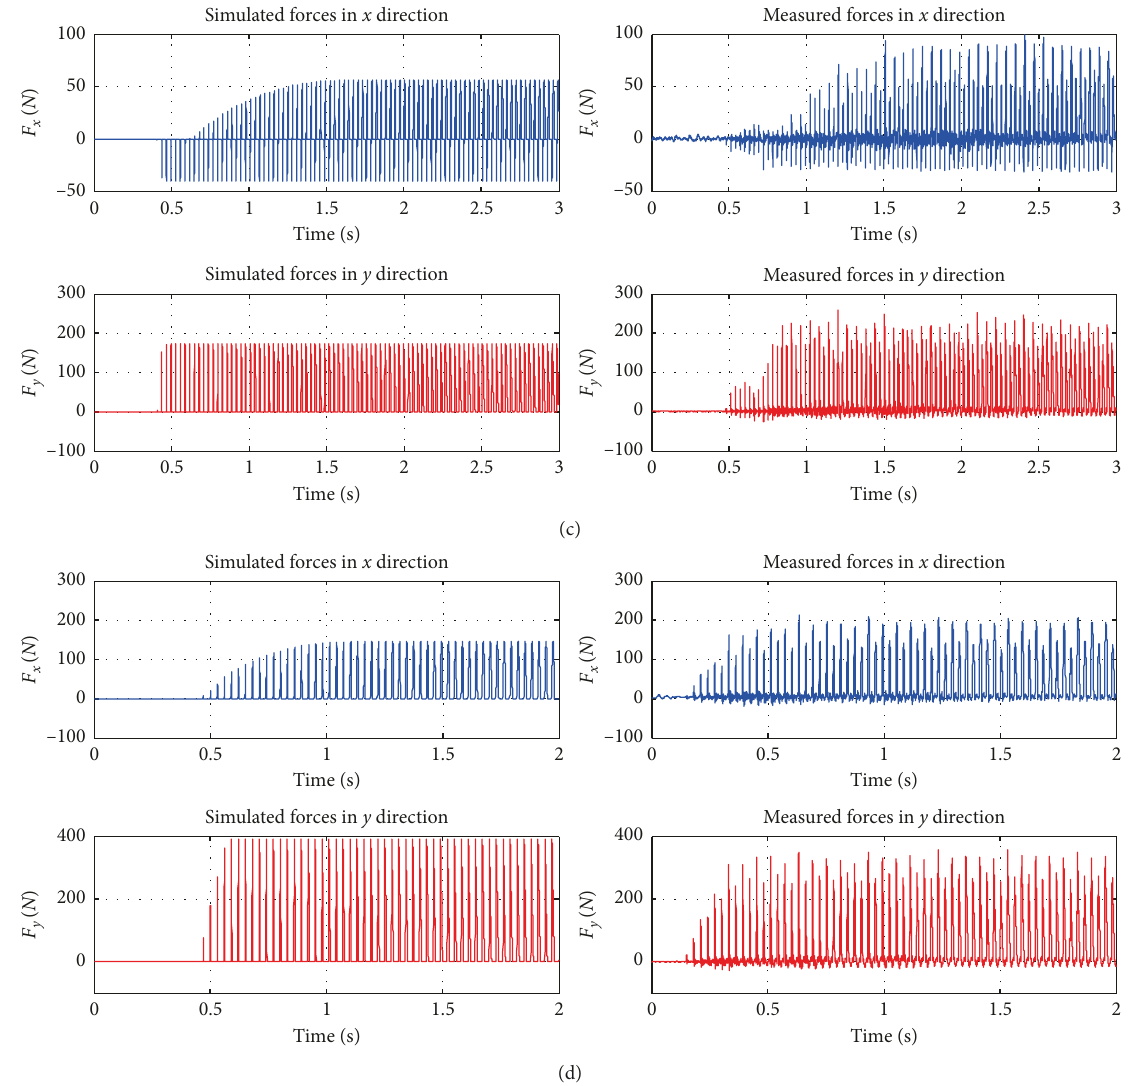
Figure 14: Simulated and measured forces when the cutter entering the workpiece along a straight line: (a) Test No. 3, (b) Test No. 6, (c) Test No. 7, and (d) Test No.